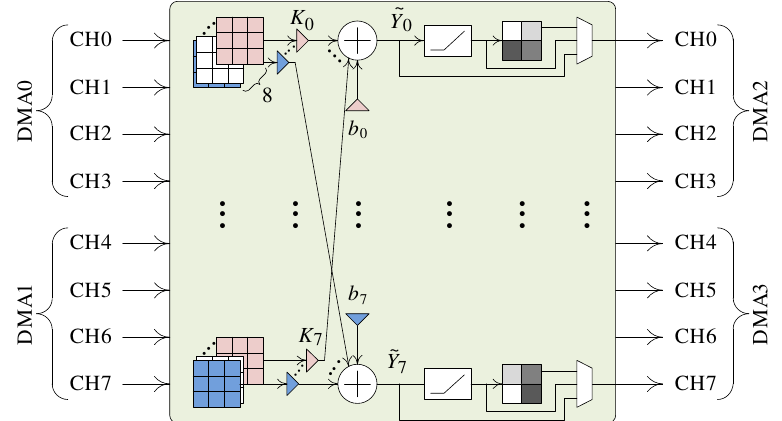
Figure 11. A core with 8 input and 8 output channels for convolution, batch normalization, ReLU and max-pooling